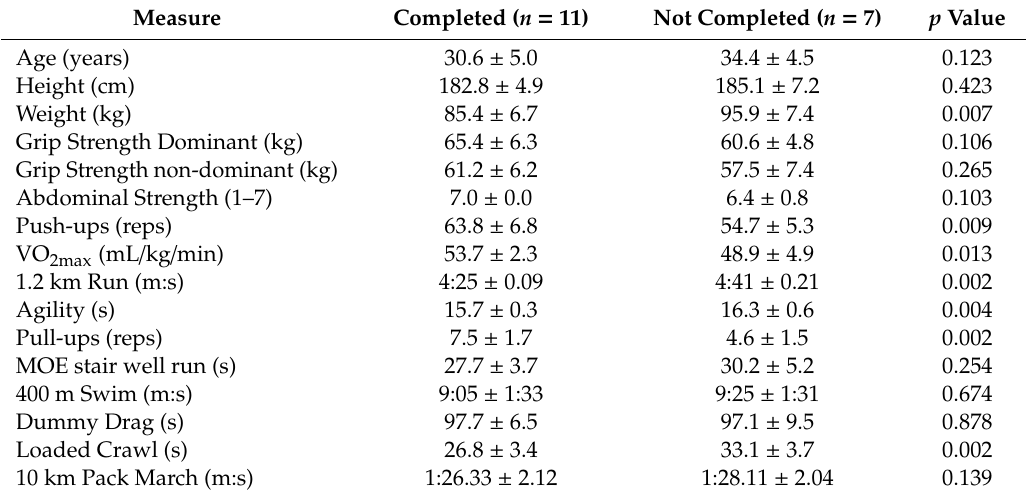
Table 1. A comparison of 18 police candidates who did and did not complete a specialist selection course. Results reported as mean ±